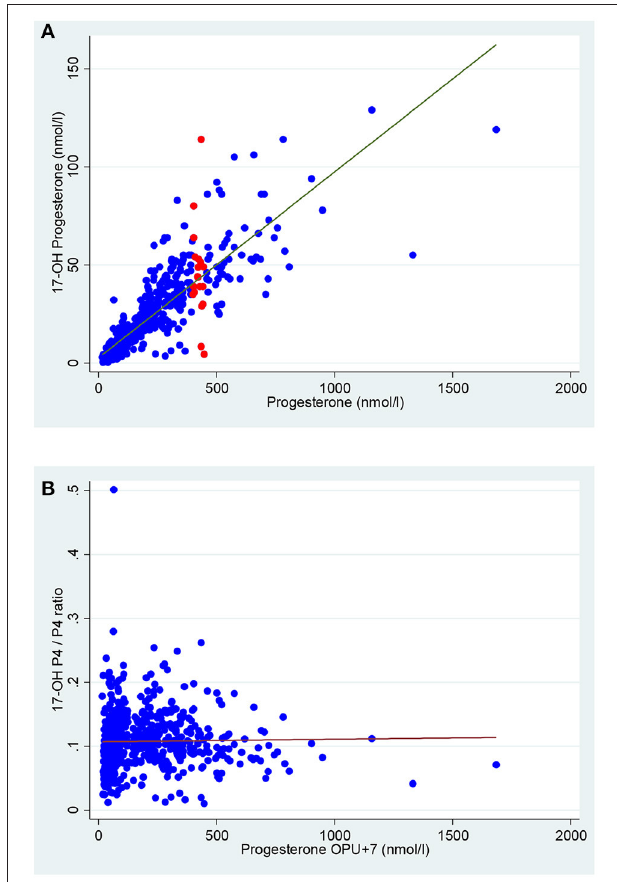
FIGURE 2 | Correlation between mid-luteal serum 17-OH P4 and serum P4 in 614 women undergoing IVF treatment. (A) A significant positive correlation was found between serum P 4 and serum 17-OH P 4 , p < 0.001.Red dots depict the 19 patients in the cohort with P 4 400–450 nmol/l. (B) The ratio between serum 17-OH P 4 and serum P 4 was constant at ∼ 10% throughout the P 4 range, p = 0.67. The linear regression line is marked in red.